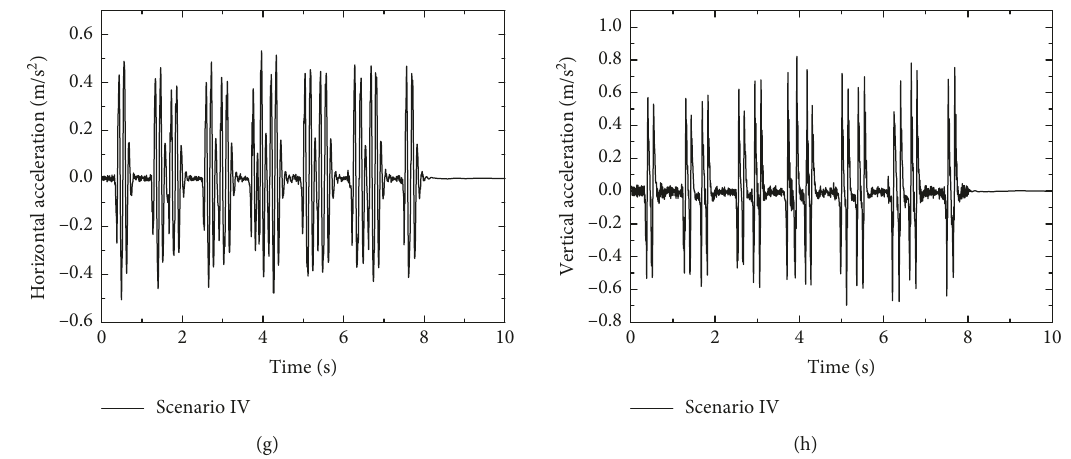
Figure 12: The acceleration curve of A 1 in time domain. (a, c, e, g) Horizontal. (b, d, f, h) Vertical.